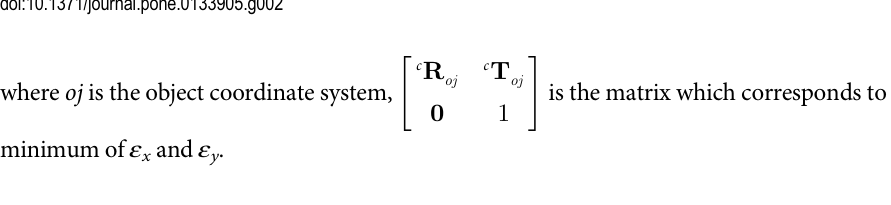
Fig 2. Geometric interpretation of POSIT. The pinhole camera with the center of projection at O c , optical axis aligned with O c , image plane uv at a distance f from O c . The origin of object coordinate system at c m = 0,1,2,3, i is the number of object ’ s position, c is the camera coordinate system, m I i is the corresponding 0 is the corresponding orthographic projecting point Pmc image point set, c i m